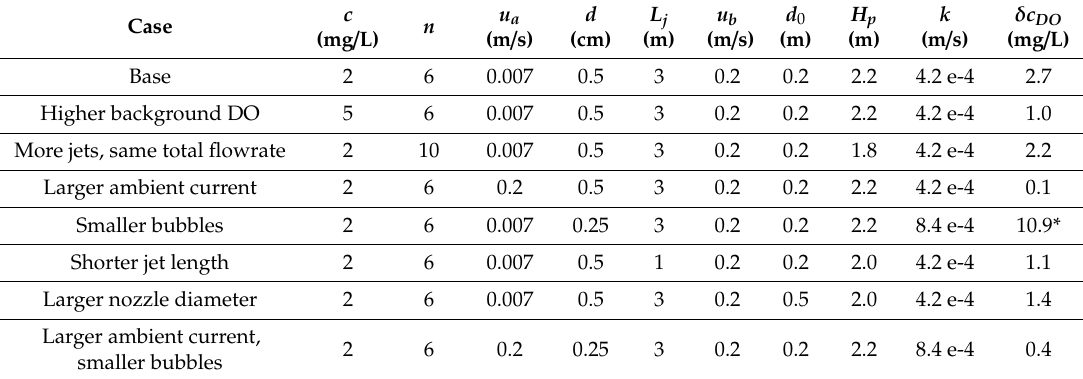
Table 3. Sensitivity of dissolved oxygen concentration change ( δ c DO ) to a variety of parameters. For all cases, the following quantities were kept constant: H = 3 m; c s = 6.8 mg / L (25 ◦ C, s = 35